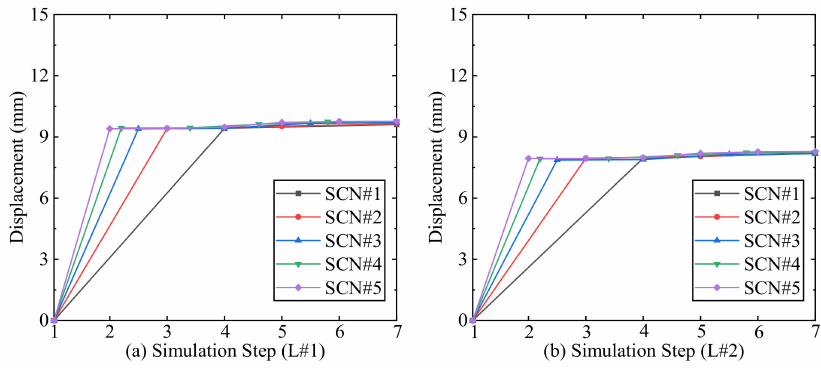
Figure 3. Displacement of sidewall middle of level #1 and level